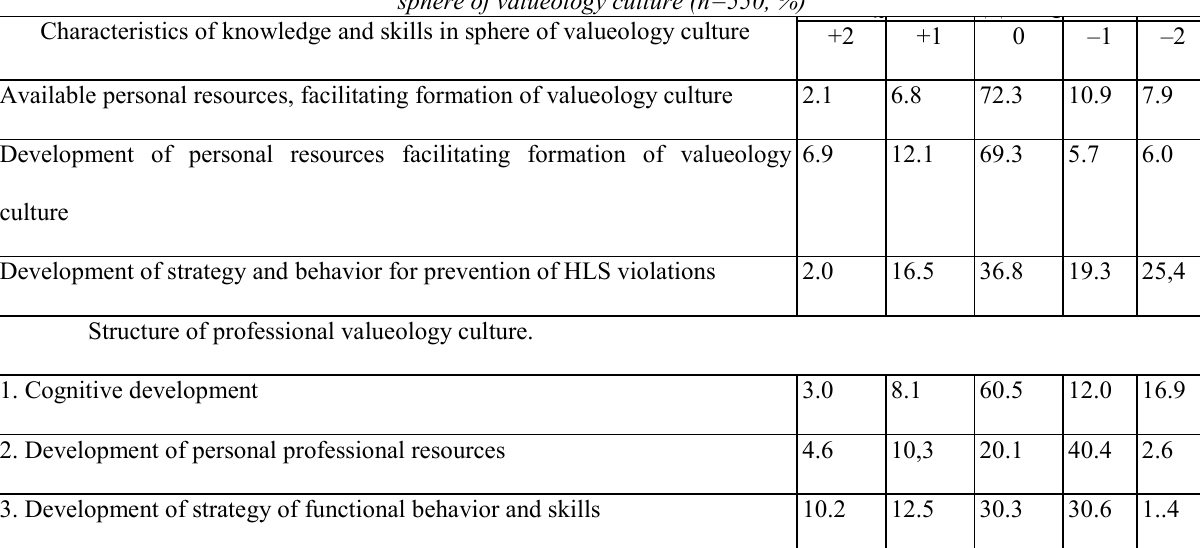
Characteristics of knowledge and skills of 3 rd -0 5 th year students of physical education and sports faculty in sphere of valueology culture (n=550,